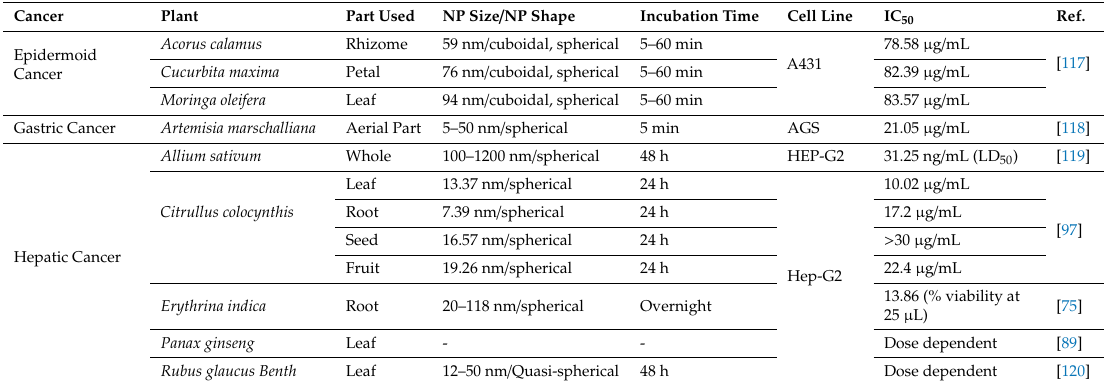
Table 4. Studies using plant extracts for the biosynthesis of AgNPs that inhibited epidermoid, laryngeal, gastronomic, hepatic, intestinal and kidney cancers cell